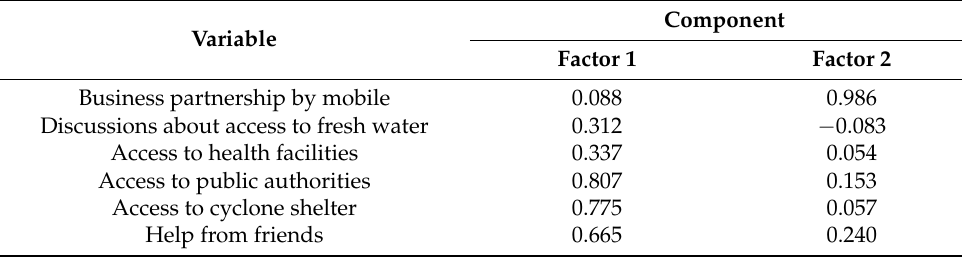
Table 10. Factor 1 alone explained over 21% of the cumulative variance. Factor 2